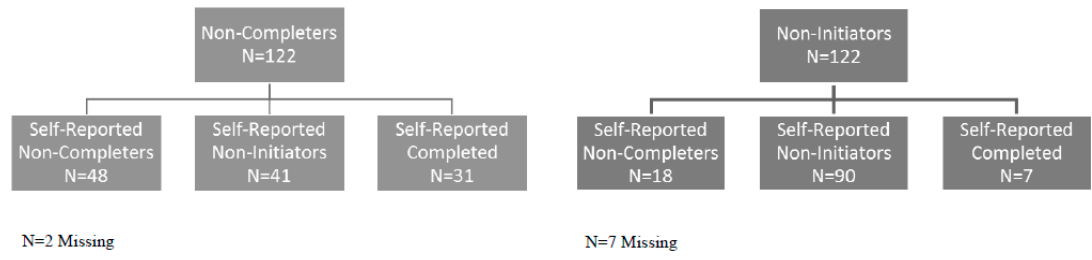
Figure 1. Electronically identified vs. self ‐ reported human papillomavirus vaccination status.